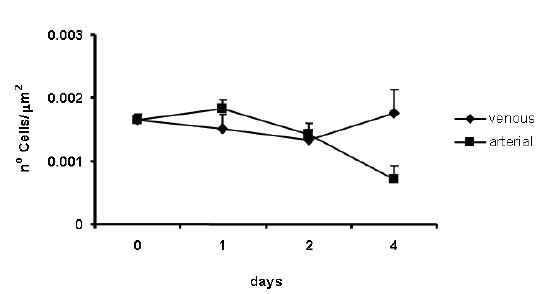
Figure 4 - Analysis of cellular density of human saphenous vein cultured in the ex vivo perfusion system. The results are expressed as mean ± standard error of total cell number per vessel area of 3-5 samples stained with Hoechst 33258. (  ) represents human saphenous vein cultured under venous condi- tions and (  ) under arterial conditions